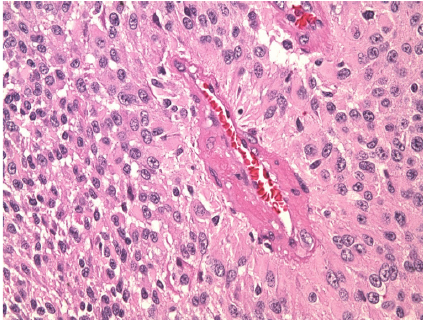
Figure 5: H&E stain demonstrating a perivascular pseudorosette with blunted end foot plates of the tumor cells directed toward a central blood vessel (40x).